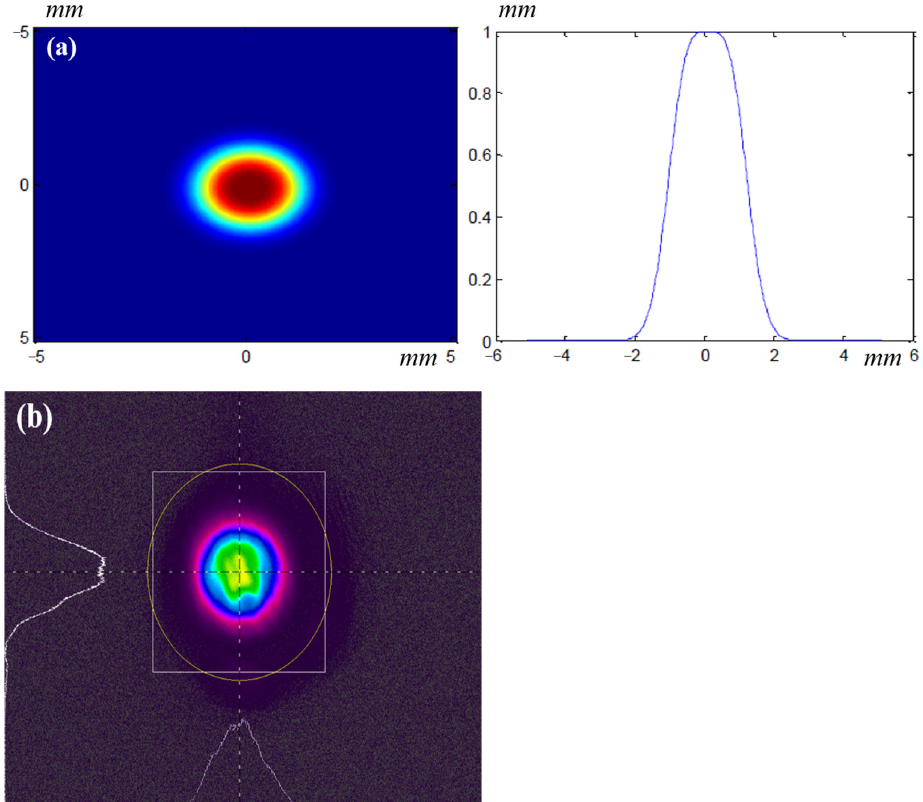
Figure 5. ( a ) Theoretical simulation, and ( b ) experimental measurement result of 1D and 2D inten ‐ sity distribution at 1 m behind the SA.